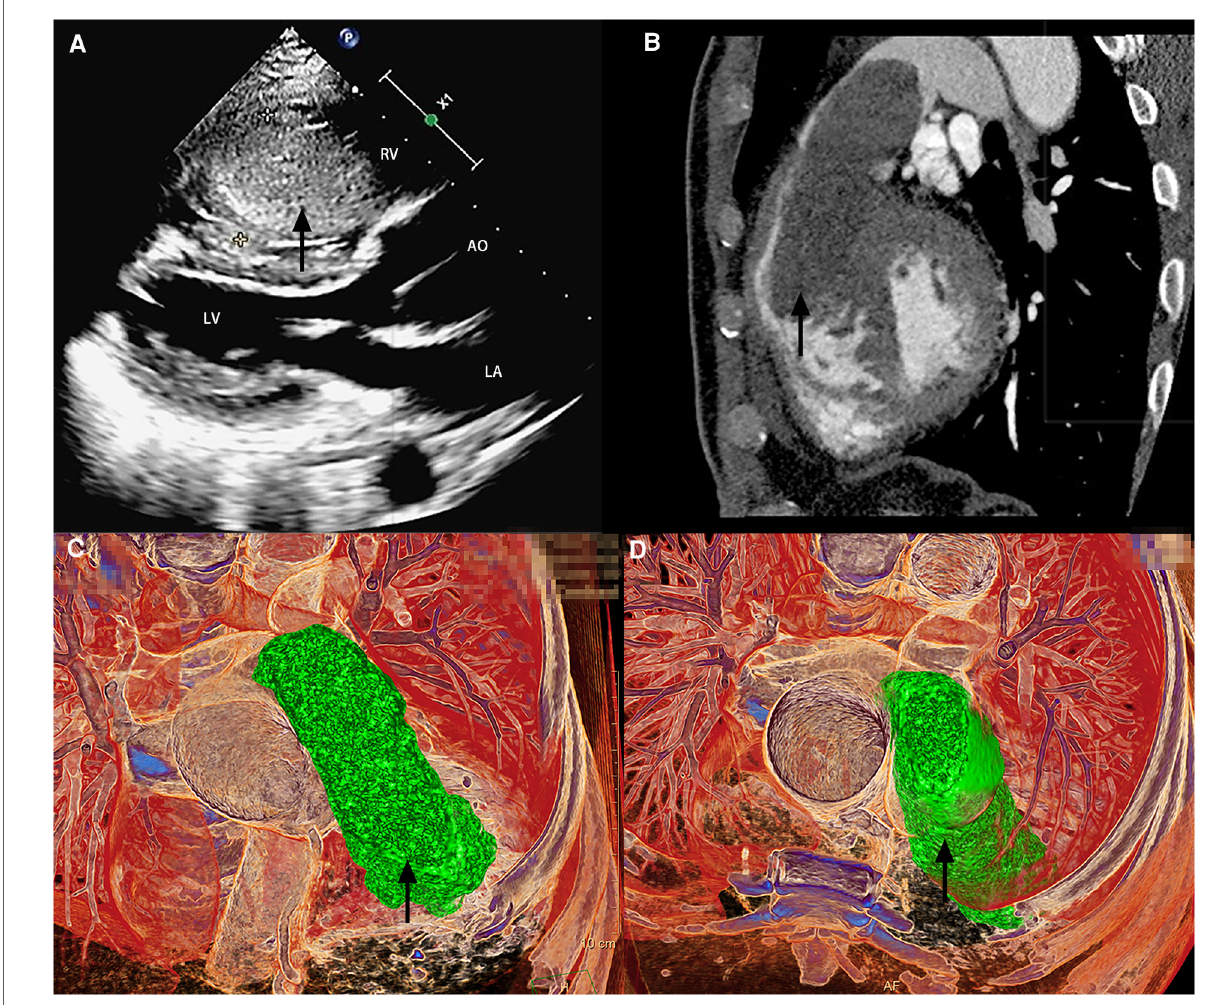
FIGURE 1 Imaging examination. Transthoracic echocardiography ( A ) and cardiac computed tomographic angiography ( B – D ) revealed a mass located within the right ventricle (black arrow). RV, right ventricle; LA, left atrium; LV, left ventricle; and AO,